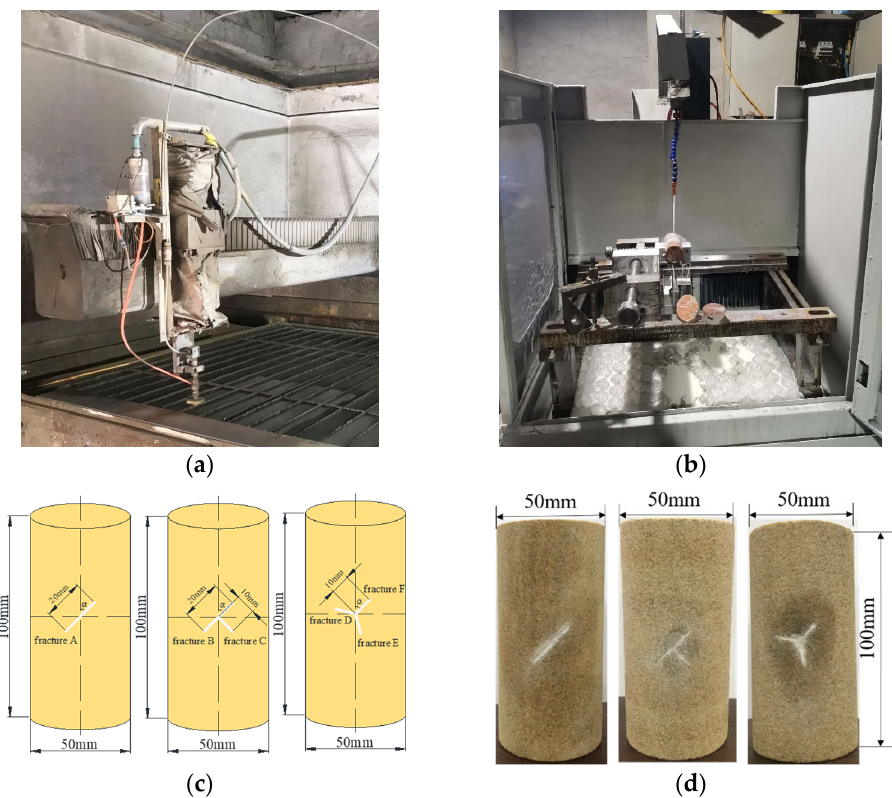
Figure 4. Processing flow of sandstone samples with prefabricated fractures: ( a ) Waterjet cutting equipment; ( b ) wire cutting equipment; ( c ) sample models; ( d ) physical images of sandstone samples.